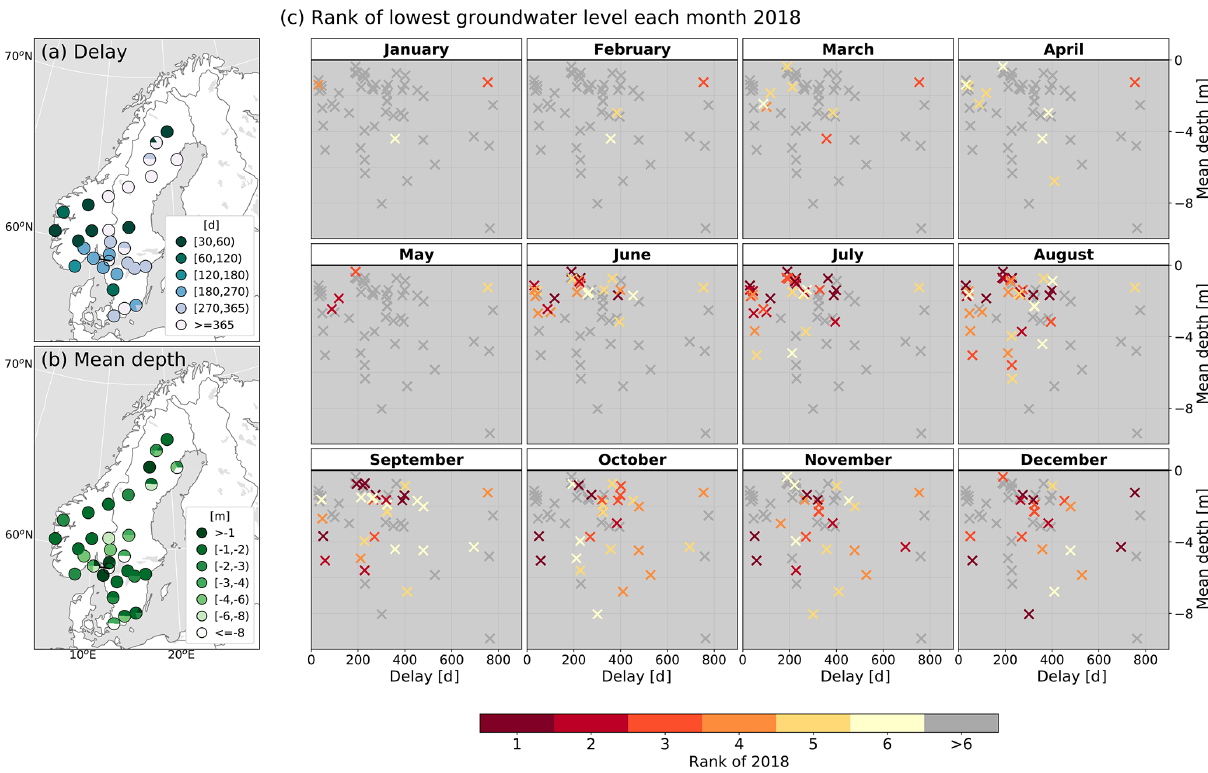
Figure 8. (a) Delay in groundwater response to precipitation, (b) mean 1989–2018 groundwater depth below surface, and (c) top-six ranking of lowest groundwater level in each month of 2018 plotted with each well’s delay and mean depth along the x axis and y axis, respectively. Two wells, one with delay of 1500d and one with mean depth of − 13 . 4m, are outside the range of the ranking plots. Those two wells had no rank of 1–6 in April–December